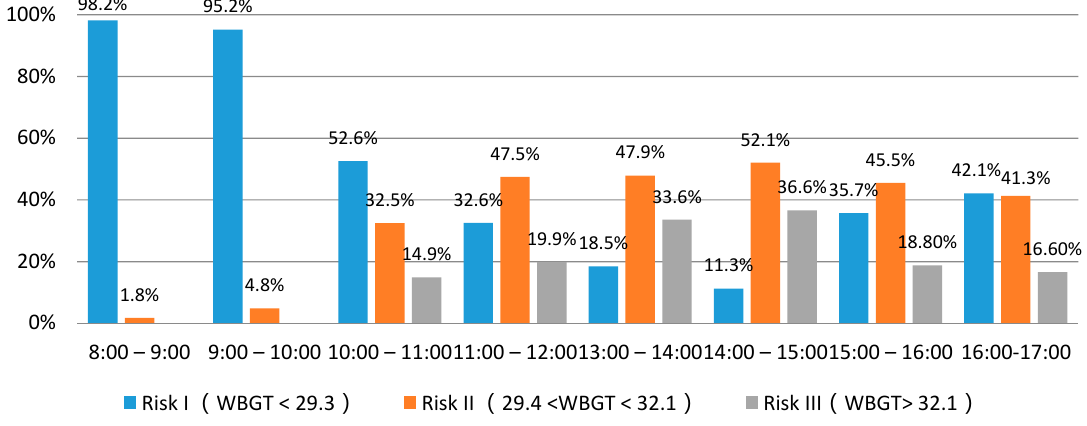
Figure 3. Distribution frequency of WBGT value in different time.